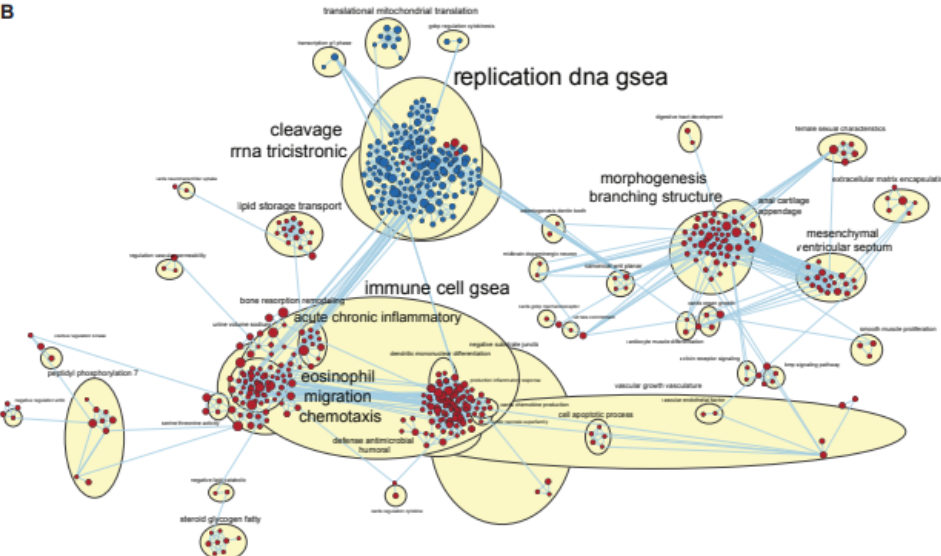
Figure 2. ASCs within the ASC-patch enhanced their regenerative transcriptome. The transcriptome of ASC in gelatin generated from 3 independent donors were assessed by microarray and compared to ASC from the same 3 donors grown in monolayer. ( A ) Heatmap of the top 25 genes with increased expression and the top 25 with decreased expression in the ASC-patch compared with ASC monolayer condition, ranked by Gene Set Enrichment Analysis (GSEA): The regulations considered to be signi fi cant were de fi ned by the calculation of a fold change (> or <2) associated with a signi fi cant p value (<0.05). ( B ) Enrichment pathways determined using the Gene Ontology Biological Process (GOBP) gene set from the Molecular Signature Database are visualized. Heatmap of the top 25 genes with increased expression and the top 25 with decreased expression in SSc EEs compared to healthy donor (HD) EEs, ranked by Gene Set Enrichment Analysis (GSEA). Red dots: up-regulated, blue dots: down-regulated ( C ) Fold change analysis on 215 selected genes involved in wound healing. The 51 statistically signi fi cant regulations are shown (fold change > 2 (up) and <2 (down) and p < 0.05, non-parametric Mann–Whitney t test). Error bars refer to SD.